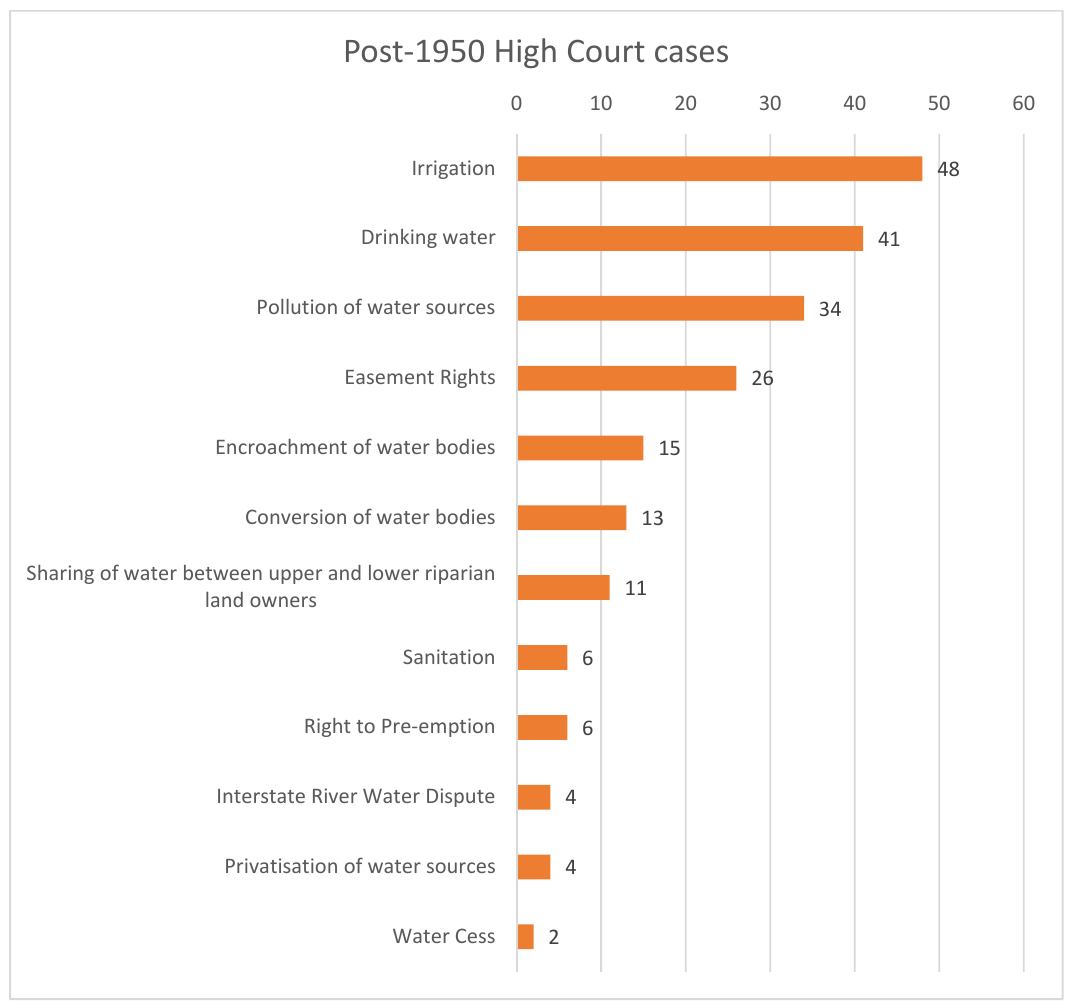
Figure 6. Overlapping distribution of claims decided by High Courts post-1950 .